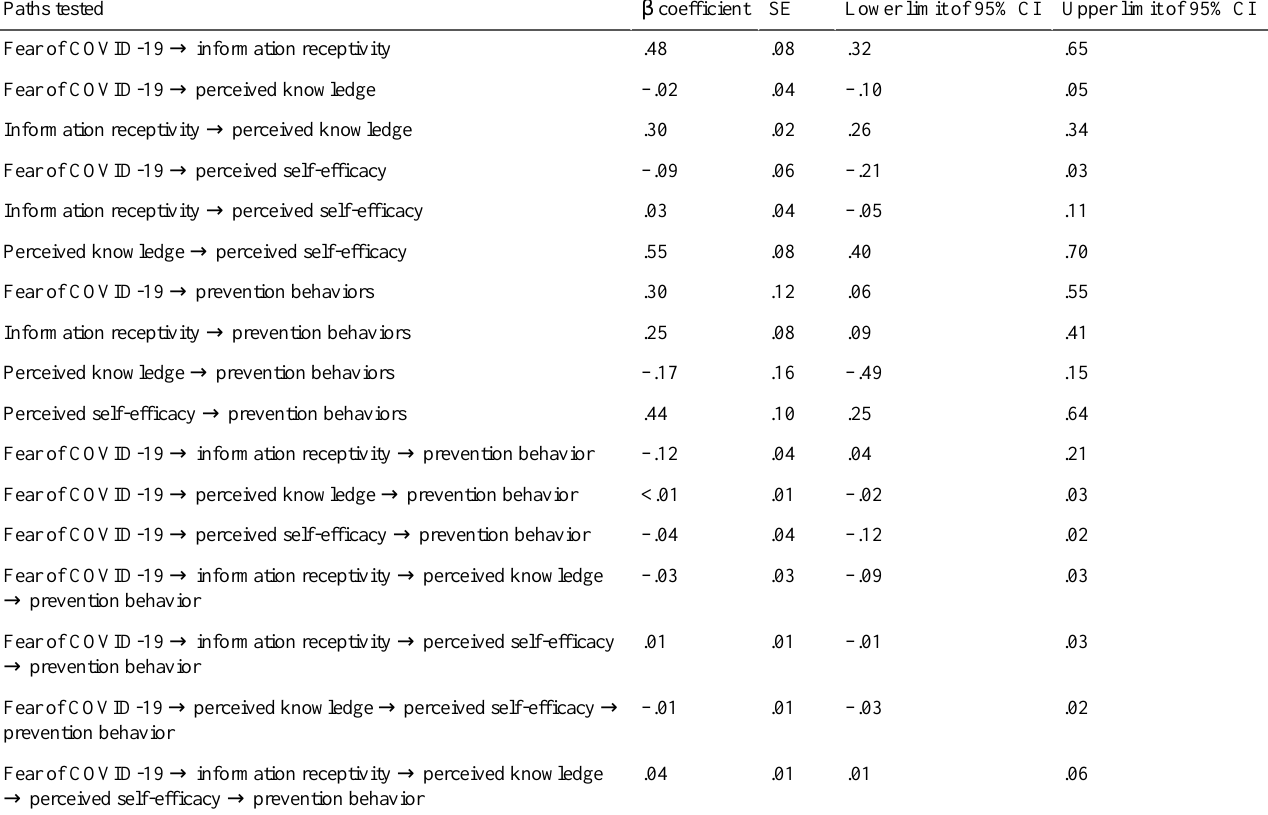
Table 1. Sequential mediation results including all direct and indirect effects a